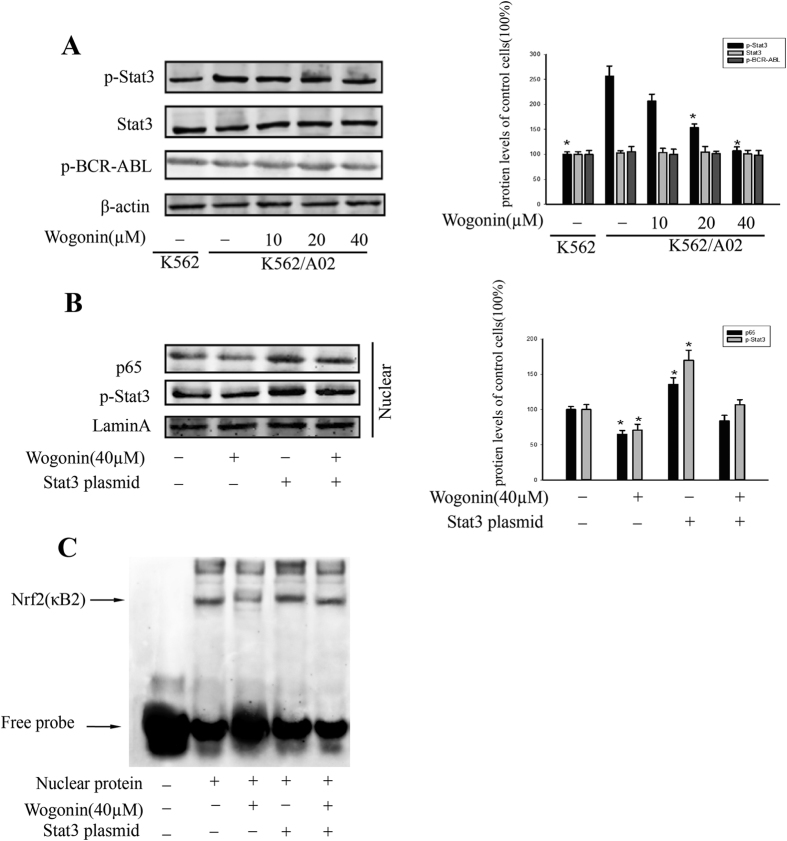
Downregulation of pY705-Stat3 was responsible for inhibition of the p65 binding activity by Wogonin.(A) After treatment with or without 40 μM Wogonin for 24 h, the expression of pY705-Stat3, p-BCR-ABL and Stat3 were examined by Western blot assays in K562/A02 cells. *p < 0.05 versus untreated K562/A02 cells. (B) Transfected K562/A02 cells with Stat3 plasmid were exposured to 40 μM Wogonin for 24 h, pY705-Stat3 and p65 were examined by Western blot. *p < 0.05 versus untreated K562/A02 cells. (C) The binding of NF-κB subunit p65 to Nrf2 sequence including κB2 site was assessed by EMSA after treatment. K562/A02 cells were transfected with Stat3 plasmid and then exposured to 40 μM Wogonin. Cell nuclear extracts were analyzed. Wogonin decreased the p65 binding activity in biotin-Nrf2 probe including κB2 regions alone, and Stat3 plasmid could reverse it. *p < 0.05 versus control. All results were represented as the mean ± SD of three independent experiments.